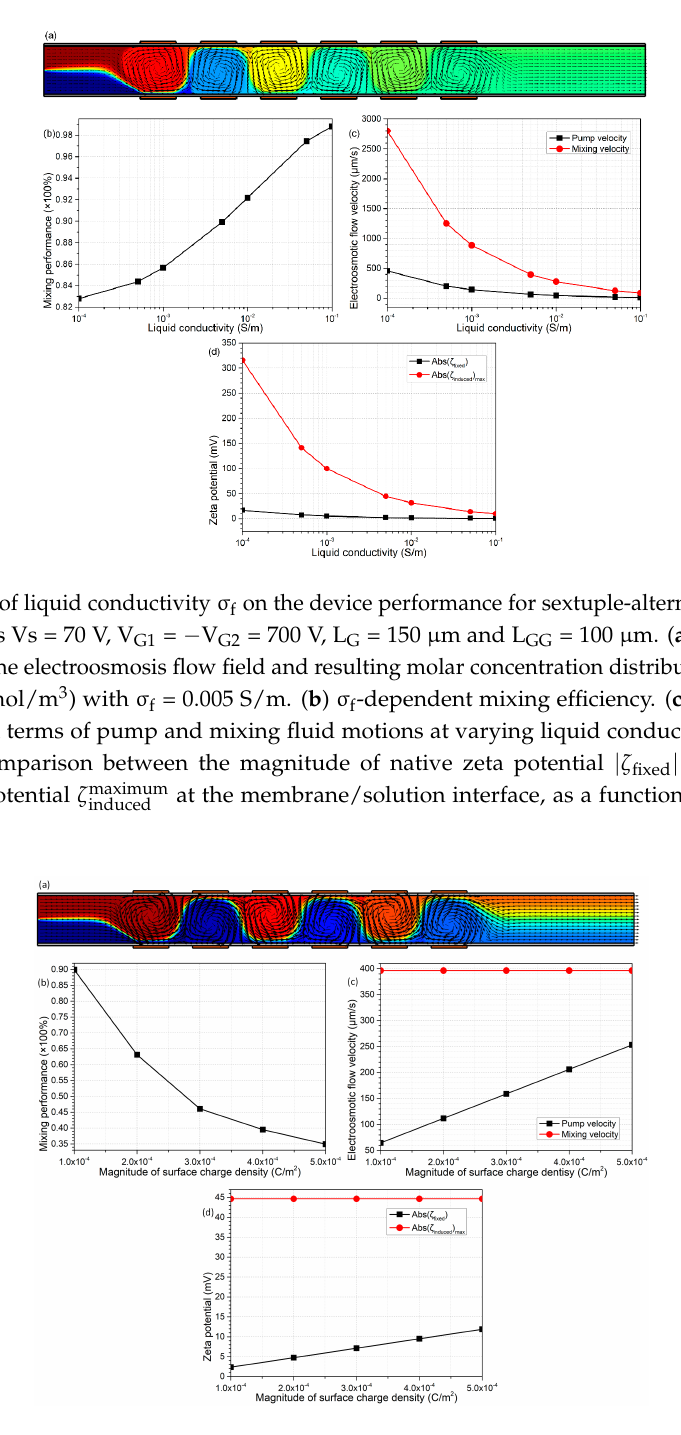
Figure 9. Effect of the absolute value of fixed surface charge density | σ free | on the dual functionalities of the sextuple-alternated B-DCFFET device, for given values of Vs = 70 V, V G1 = − V G2 = 700 V, L G = 150 µ m, L GG = 100 µ m and σ f = 0.005 S/m. ( a ) An arrow and surface plot of electrokinetic streamlines and analyte concentration distribution (unit: mol/m 3 ) with σ free = –0.0002 C/m 2 . ( b ) | σ free | -dependent device mixing performance. ( c ) Electroosmotic pumping and mixing flow velocity for varying values of | σ free | . ( d ) A quantitative comparison between the magnitude of native zeta potential | ζ fixed | and the maximum induced zeta potential ζ maximum at the membrane/electrolyte interface, as a function of the induced magnitude of the fixed surface charge density | σ free | on channel